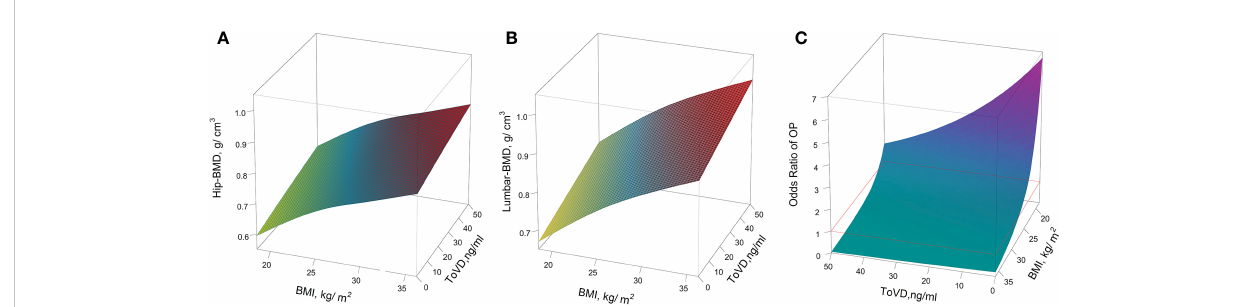
FIGURE 5 The predictive values for the outcomes of BMD biomarkers and OP risk, as functions of ToVD (ng/ml) and BMI (kg/m 2 ). (A) Hip-BMD; (B) Lumbar- BMD; (C) OP. The yellow-colored region maps indicate the lower levels of the BMD area, and the red-colored area corresponds to the higher level of the BMD area; In the plot of the expression levels of Lumbar-BMD according to ToVD levels and BMI, The yellow-colored region maps the lower level of the BMD area, whereas the red-colored area corresponds to the higher level of the BMD area; In the plot of OP risk trajectory according to ToVD levels and BMI, compared with the reference values, the cyan-colored region maps the lower risk area and the red violet colored area corresponds to the higher risk area. Red lines are used to illustrate reference risk levels ( OR =1, subjects with BMI = 24 kg/m 2 and ToVD = 20.88 ng/ ml as reference). In all panels, multivariate analyses were adjusted for age (in years, continuous), sex (men or women), educational status, smoking status, drinking status, dietary types, family income levels, seasons, regions and MAHS (in hours, continuous). The missing data were imputed by multiple imputation and all estimations were combined across the 5 imputed datasets using the Rubin ’ s method. ToVD, total 25(OH)D; Hip-BMD, hip bone mineral density; Lumbar-BMD, lumbar bone mineral density; OP, osteoporosis; OR, odds ratio; MAHS, mean annual hours sunshine; BMI, body mass